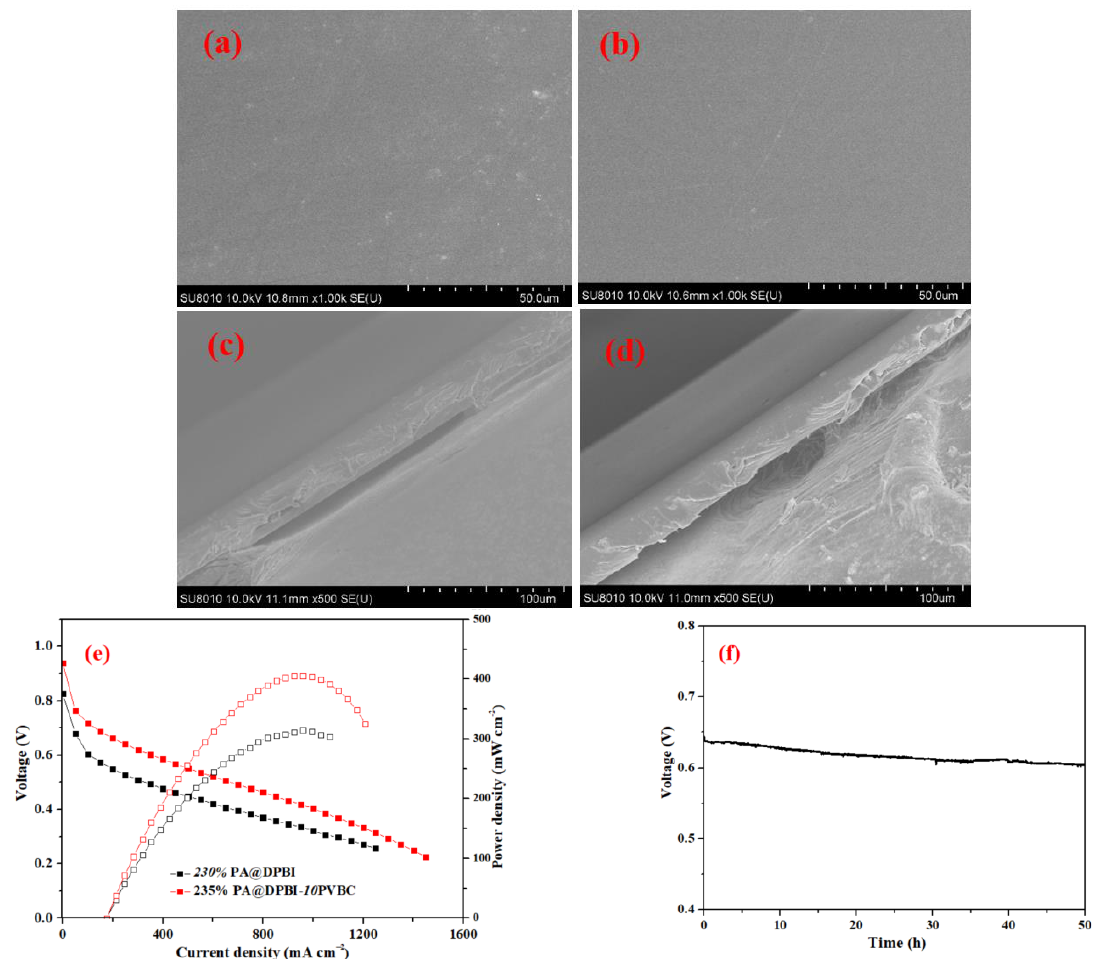
Figure 4. SEM micrographs of the surface (up) and cross-section (down) of the membranes: ( a , c ) DPBI, and ( b , d ) DPBI- 10 PVBC; ( e ) Polarization curves at 160 °C with flow rates of 80- and 160-mL min-1